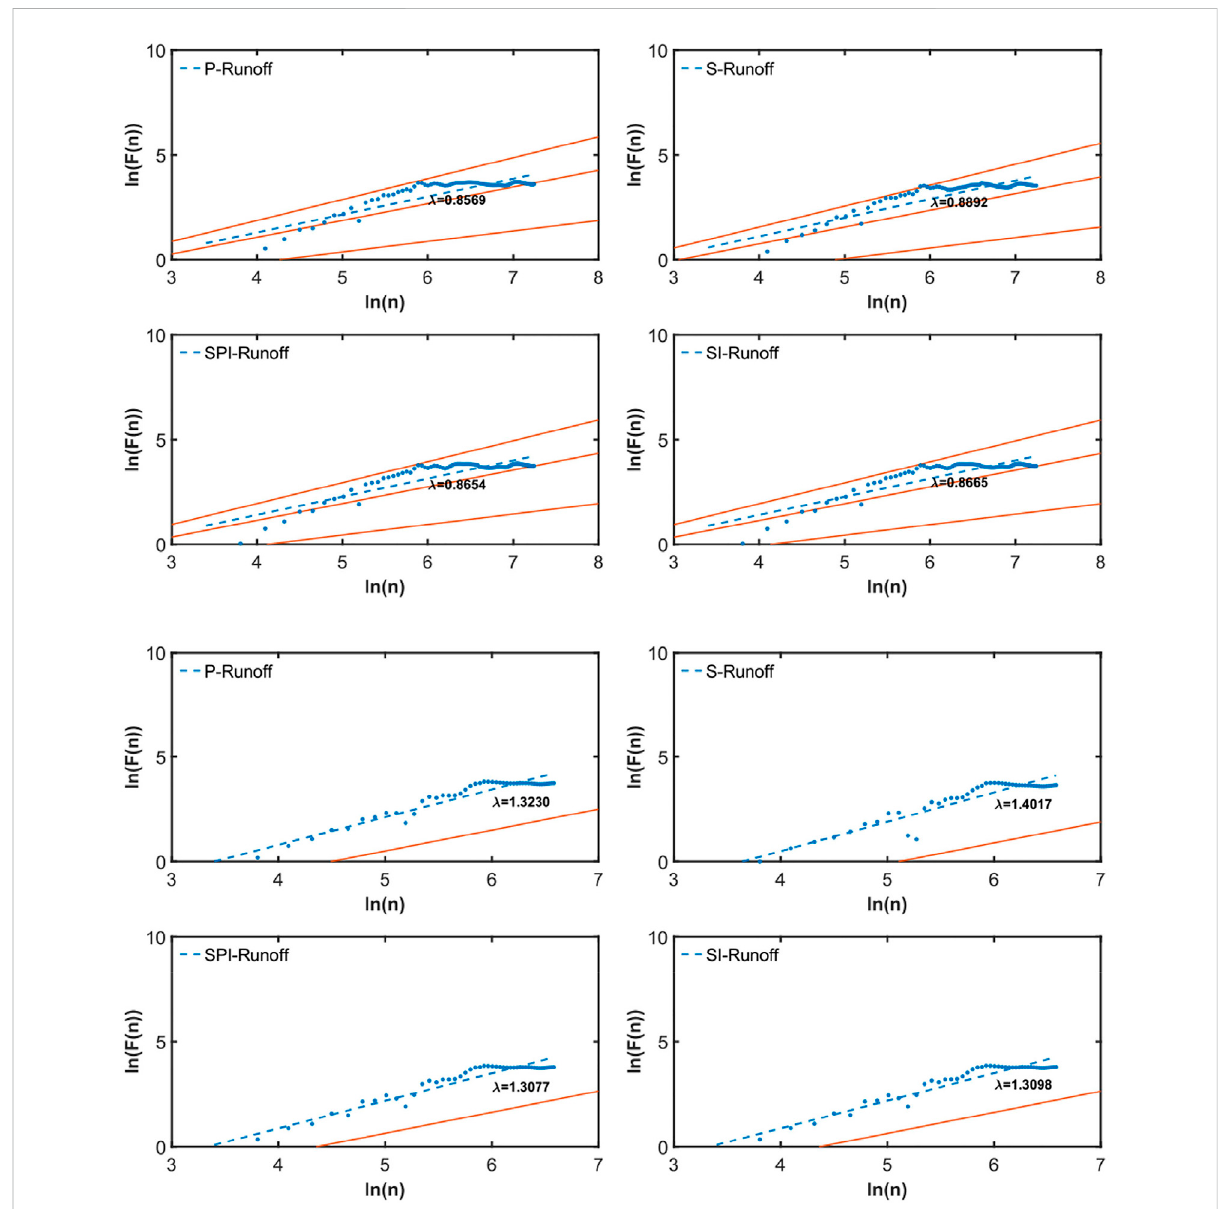
FIGURE 13 Power-law cross-correlations between ANN-reconstructed (upper four subplots) and ANN-forecasted (lower four subplots) runoff and in-situ TC-CD runoff. The slopes of dashed blue lines represent the fi tted λ DCCA , and the three red solid lines from top to bottom denote λ DCCA (cid:1) 1, λ DCCA (cid:1) 0 . 8, and λ DCCA (cid:1) 0 . 5,